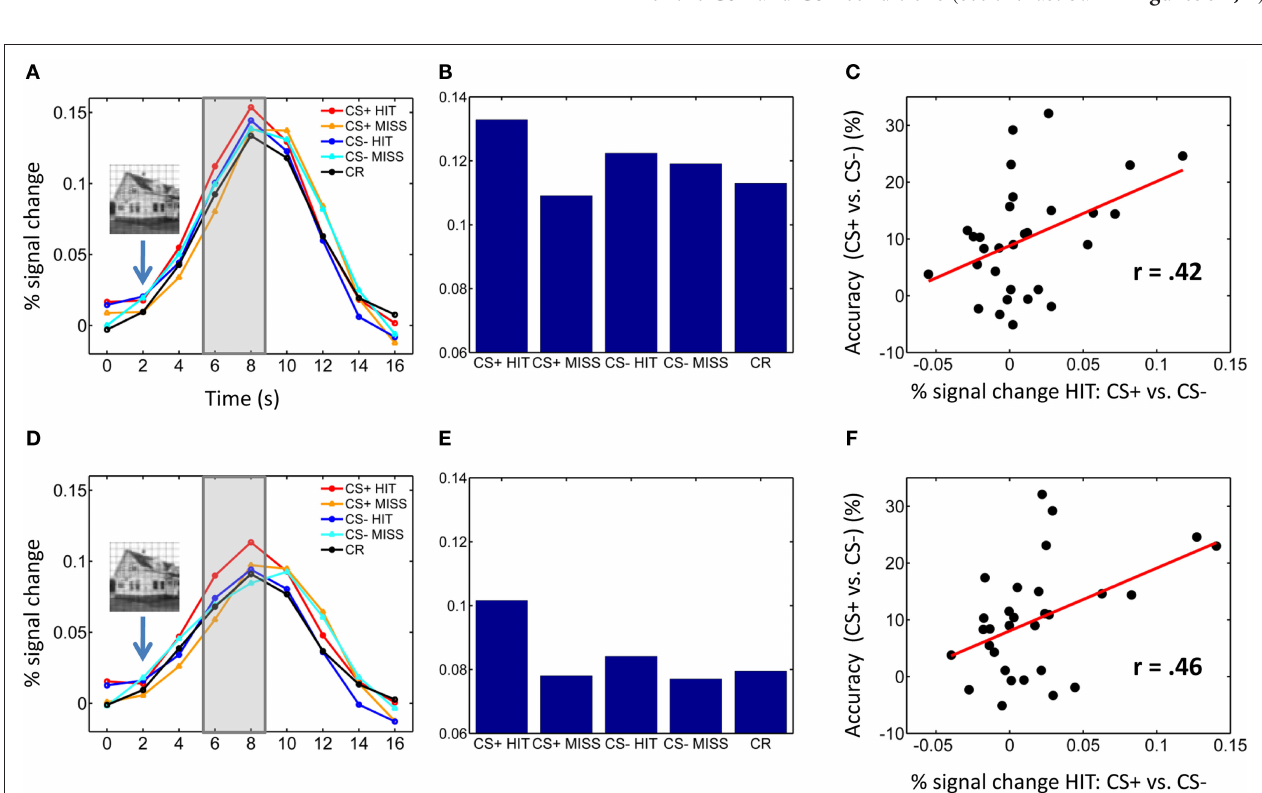
Figure 2 | Pulvinar responses. (A–C) Left pulvinar responses. (A) Average time-courses of evoked responses in the left pulvinar ROI as a function of experimental condition. Evoked responses of individual trials were based on the average of time points at 6 and 8 s post trial onset (see shaded area) – i.e., 4–6 following T2 presentation (indicated schematically via the inset containing the house stimulus). (B) Bar plots showing the same data as in (A) based on the